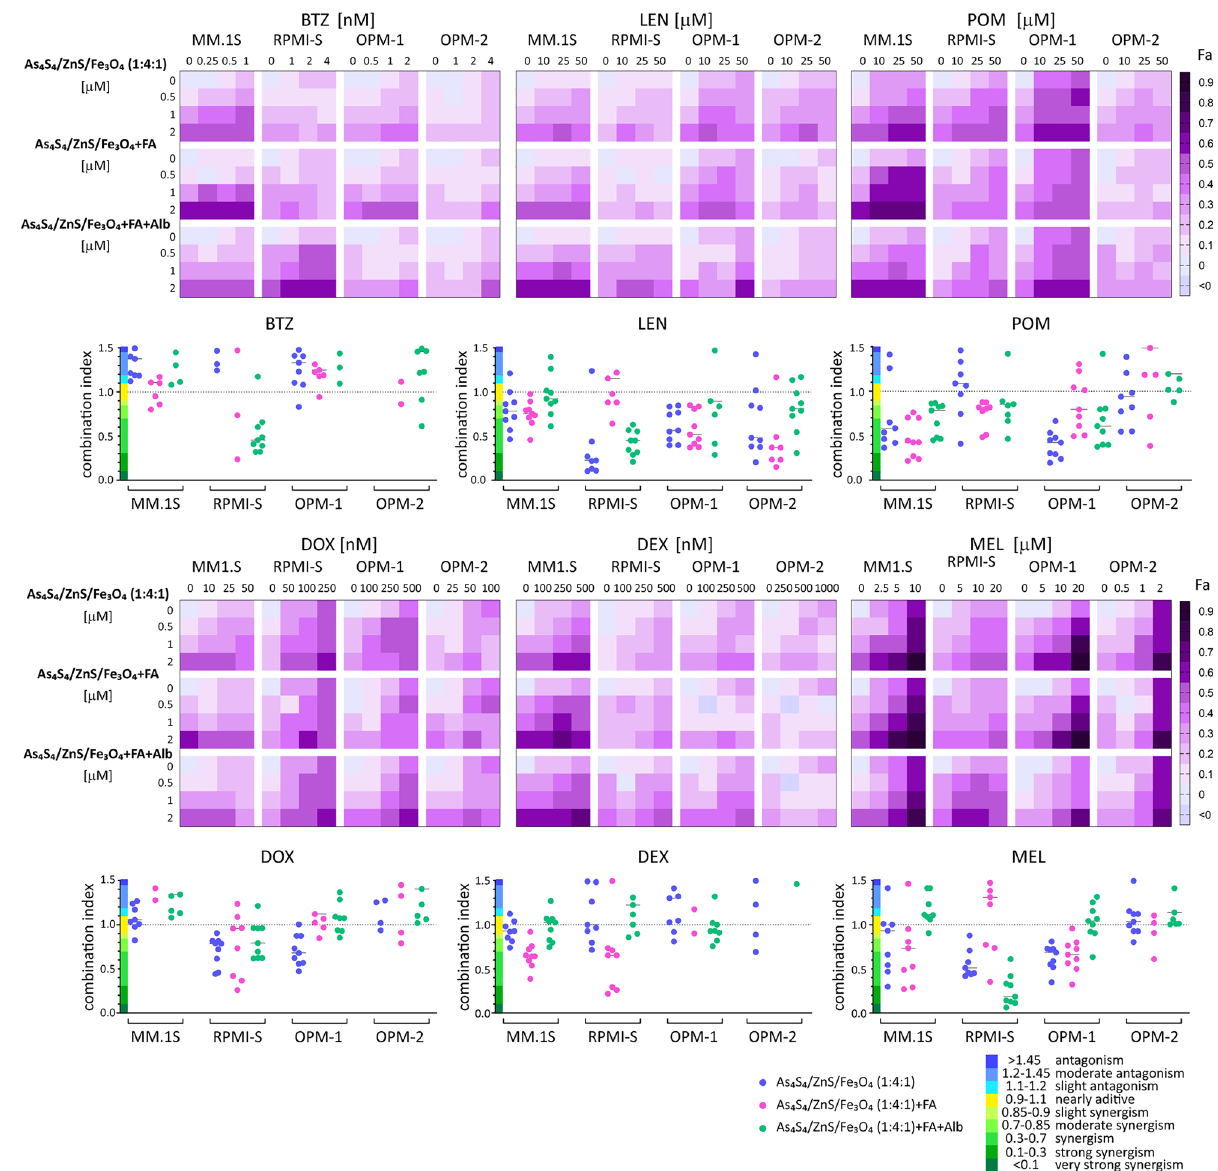
Figure 7. As 4 S 4 /ZnS/Fe 3 O 4 (1:4:1), As 4 S 4 /ZnS/Fe 3 O 4 (1:4:1) with FA, and As 4 S 4 /ZnS/Fe 3 O 4 (1:4:1) with FA and Alb enhance the effect of anti-MM agents in vitro. MM.1S, RPMI-S, OPM-1, and OPM-2 cells were cultured with all 3NPs in combination with novel anti-MM drugs: bortezomib (velcade; BTZ), lenalidomide (LEN) and pomalidomide (POM) and conventional anti-MM drugs: doxorubicin (DOX), dexamethasone (DEX) and melphalan (MEL) for 48 h. Cell viability was then assessed using the MTT assay. Fractions-affected (Fa—ratio of number of nonviable MM cells/total number of MM cells) cells was visualized in a color-coded format and compared to treatment with each drug alone. Isobologram analysis was performed to calculate the combination index (CI) for each combination by the Chou–Talalay method. The x-axis corresponds to the fractional effect at various combination doses and the y-axis represents the CI; CI < 1 indicates drug synergy, whereas CI = 1 is considered additive, and CI > 1 indicates antagonism. All experiments were performed in triplicate. Data represent mean (± standard deviation) of triplicate